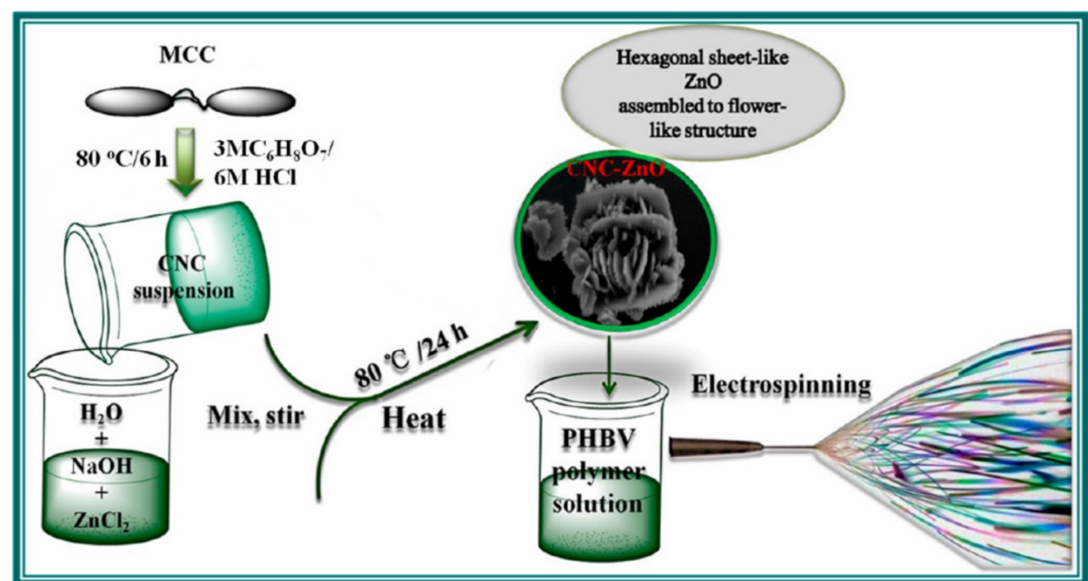
Figure 4. Schematic illustration of possible experimental preparation procedure of sheet-like CNC- ZnO nanohybrids and their electrospinning process [69]. Copyright 2018 American Chemical